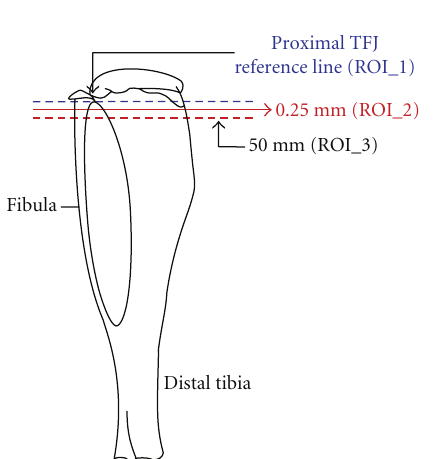
Figure 2: pQCT regions of interest in the proximal tibiae of mice. Distances of scanned slices from the proximal tibiofibular